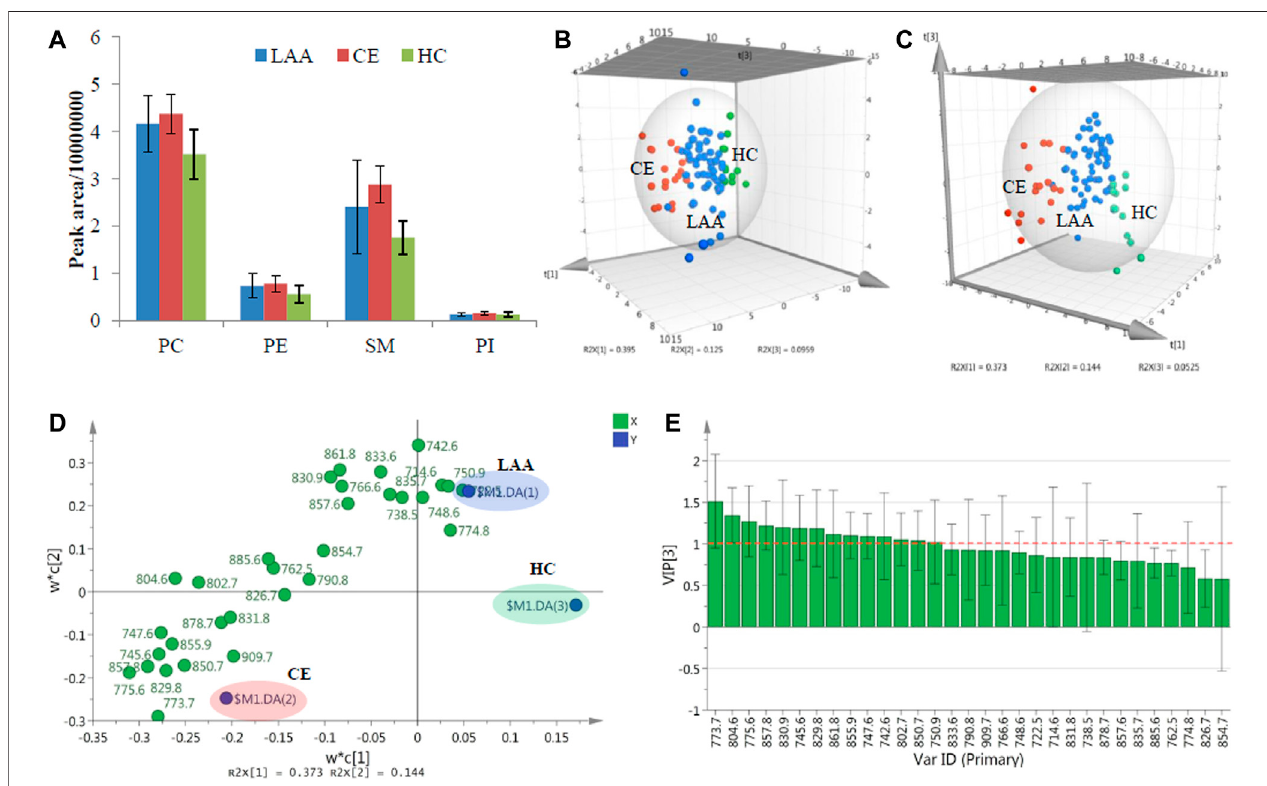
FIGURE 2 | (A) . The mean TIC peak areas of four detected PL classes in LAA, CE, and HC groups; The 3D PCA score plot (B) , 3D PLS-DA score plot (C) , 2D PLS-DA loading plot (D) and VIP plot (E) of the determined concentration results of PL molecular species in LAA, CE, and HC